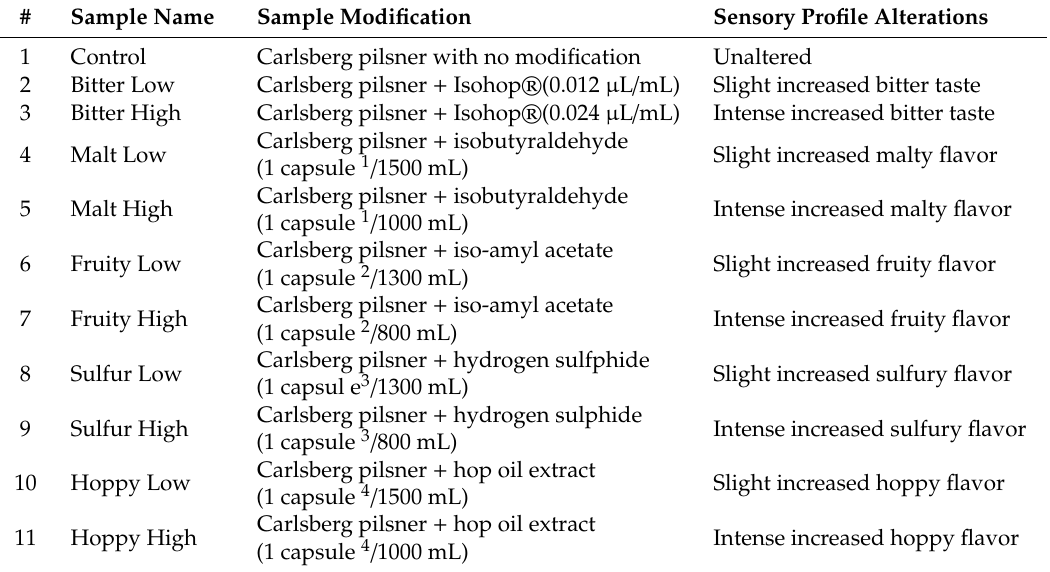
Table 1. Sample overview with specification of